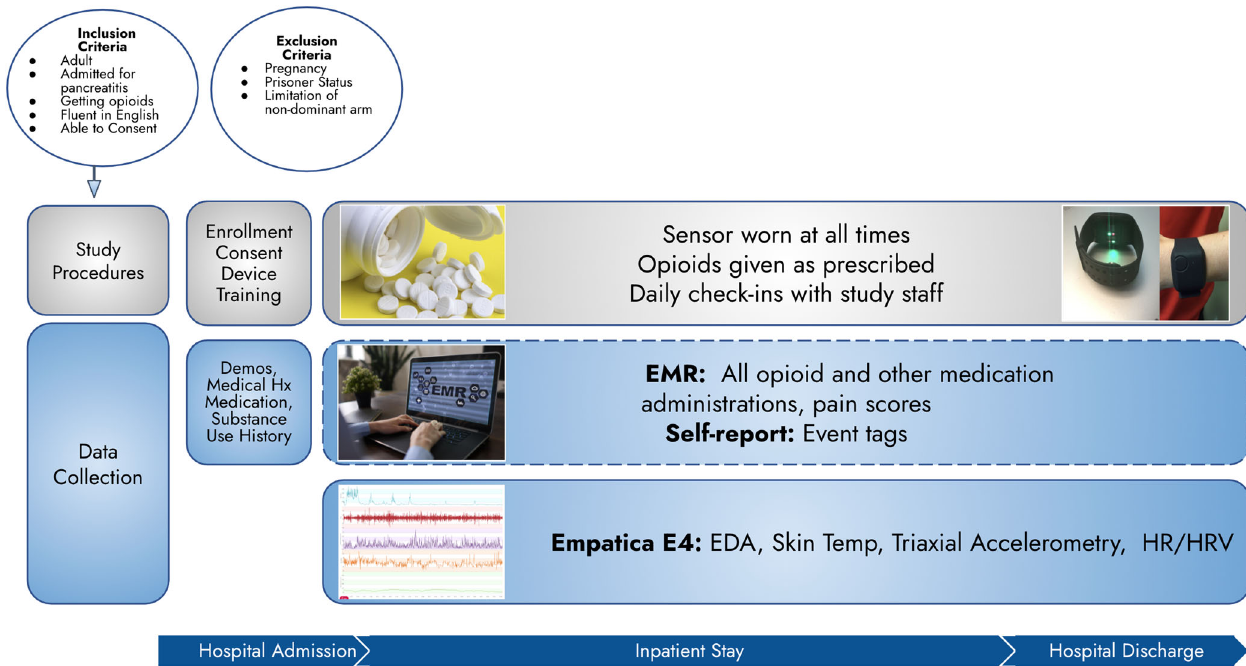
Fig. 8 Flow diagram of study participation. BMI Body Mass Index, EMR Electronic Medical Record, EDA Electrodermal Activity, HR Heart Rate, HRV Heart Tare Variability.